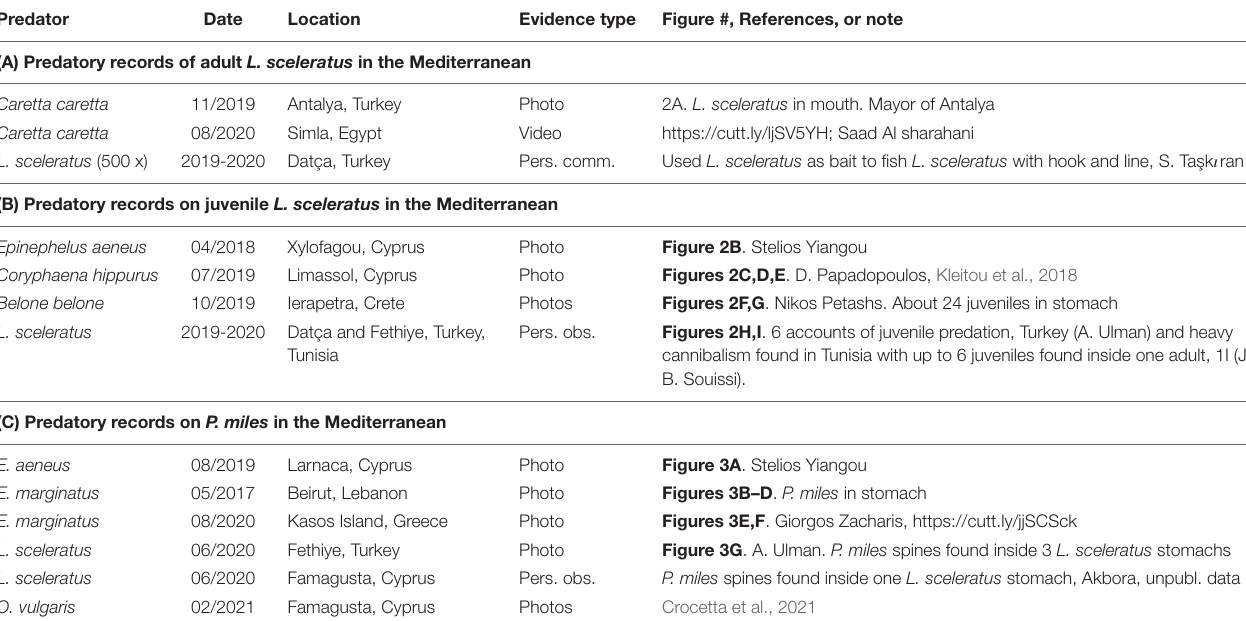
TABLE 2 | Predatory records on Lagocephalus sceleratus and Pterois miles in their Mediterranean invaded ranges; photo credits after Figure reference. Predator